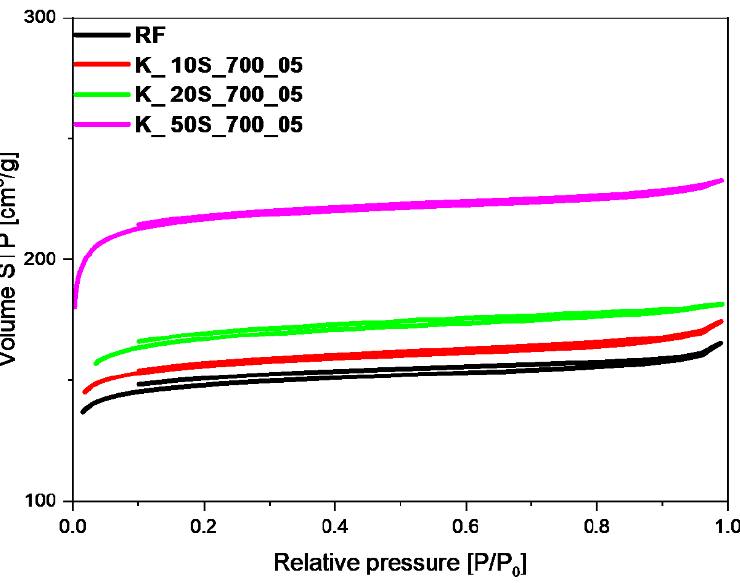
Figure 2. Nitrogen adsorption-desorption isotherms of reference material (RF) and samples activated using solid-based method with different KOH content.